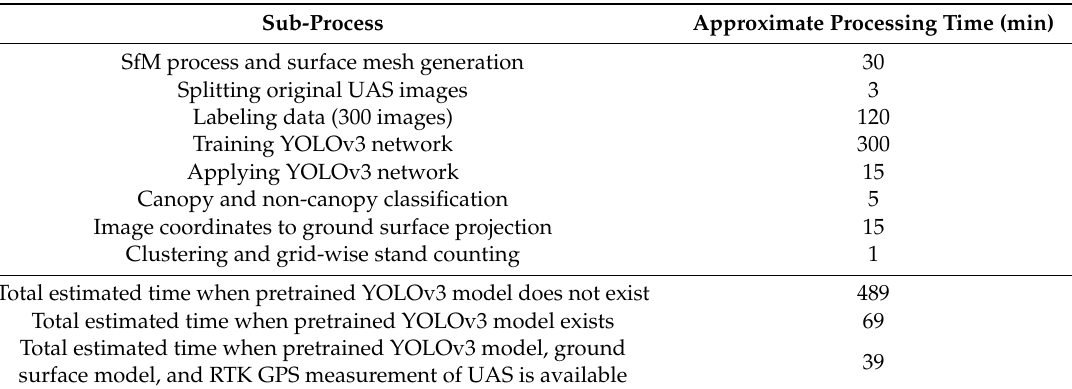
Table 6. Estimated processing time of the proposed approach in a 40 m by 10 m